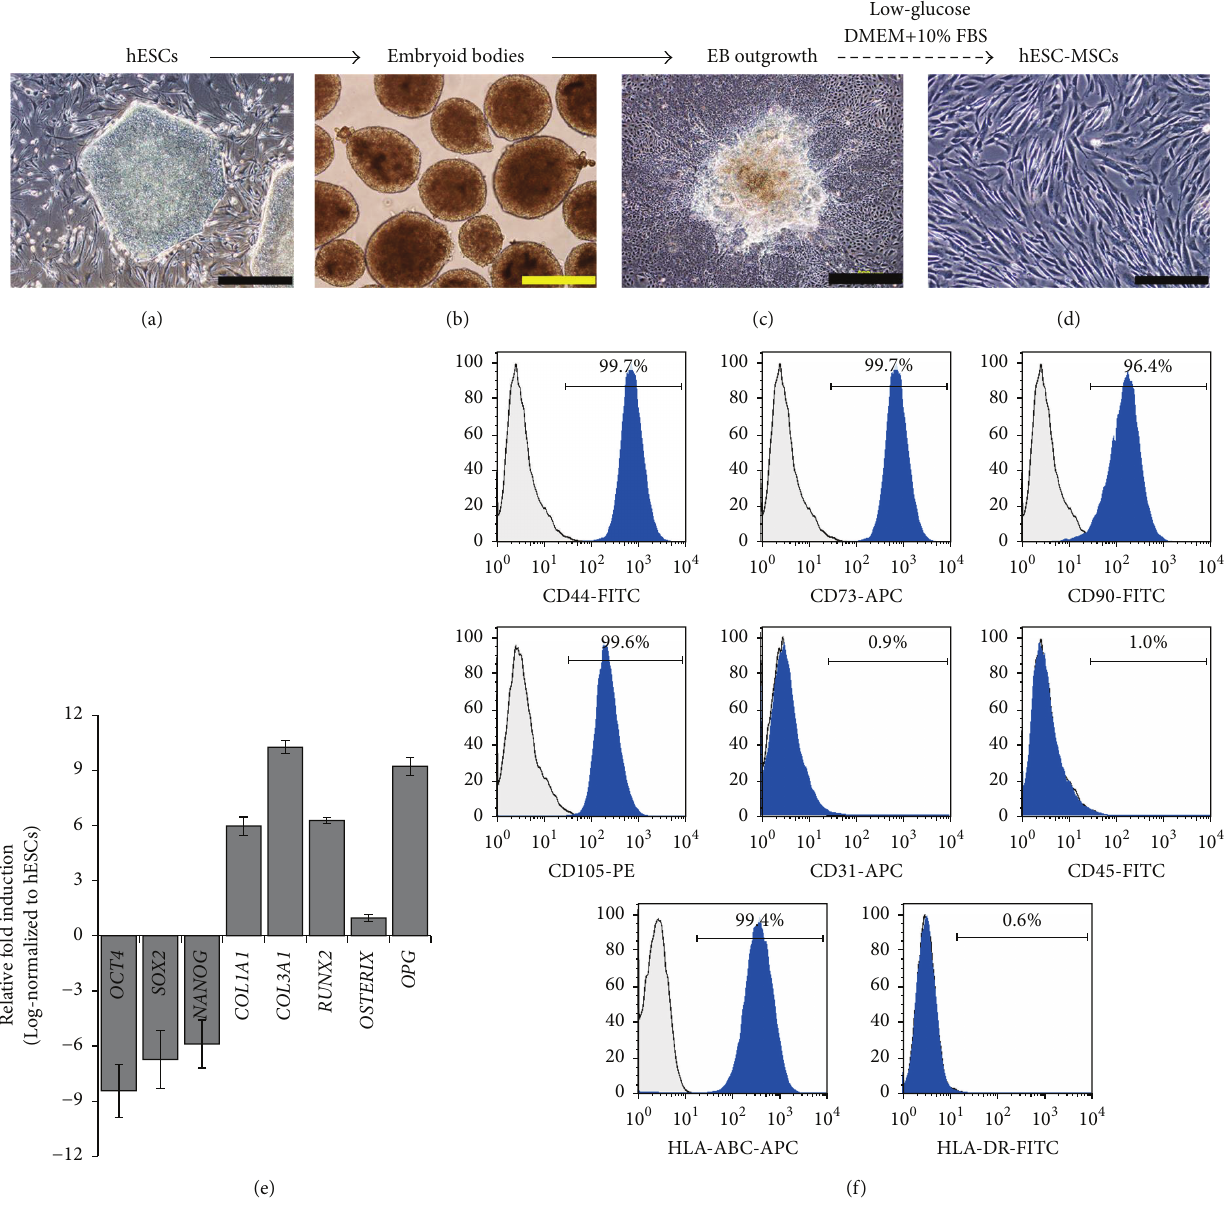
Figure 2: Differentiation of hESCs to hESC-MSCs. (a–d) The photomicrographs demonstrate the differentiation of hESCs to hESC-MSCs throughembryoidbodiesandembryoidbodyoutgrowthunderlow-glucosedifferentiationconditions.(e)CharacterizationofhESC-MSCsby real-time RT-PCR for pluripotency (OCT4, SOX2, and NANOG) and mesenchymal ( COL1A1 , COL3A1 ) and osteogenic ( RUNX2 , OSTERIX , and OPG ) lineage associated transcripts. (f) Flow cytometry characterization of hESC-MSCs for expression of surface markers. Scale bar in (a) and (c): 500 𝜇 m. Scale bar in (b) and (d): 200 𝜇